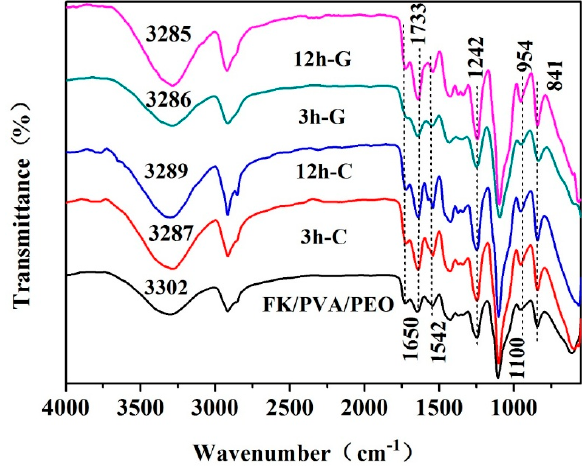
Figure 2. The FTIR spectra of as-prepared and crosslinked FK/PVA/PEO nanofiber membranes.